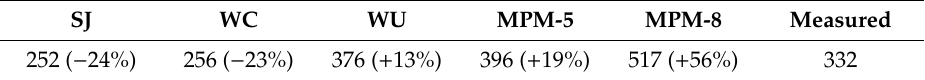
Table 4. Calculated and measured total sediment load (kg × 10 3 ) for the step-wise flood event of Figure 2b in a dimension of